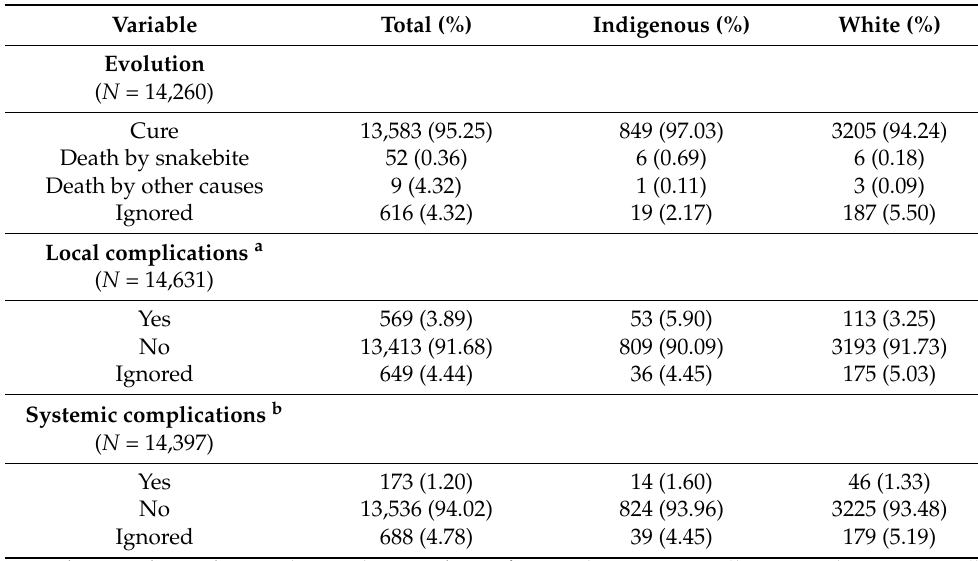
Table 4. Evolution of snakebite cases (death by snakebite, local complication, systemic complication), by race, rural population, Brazil,